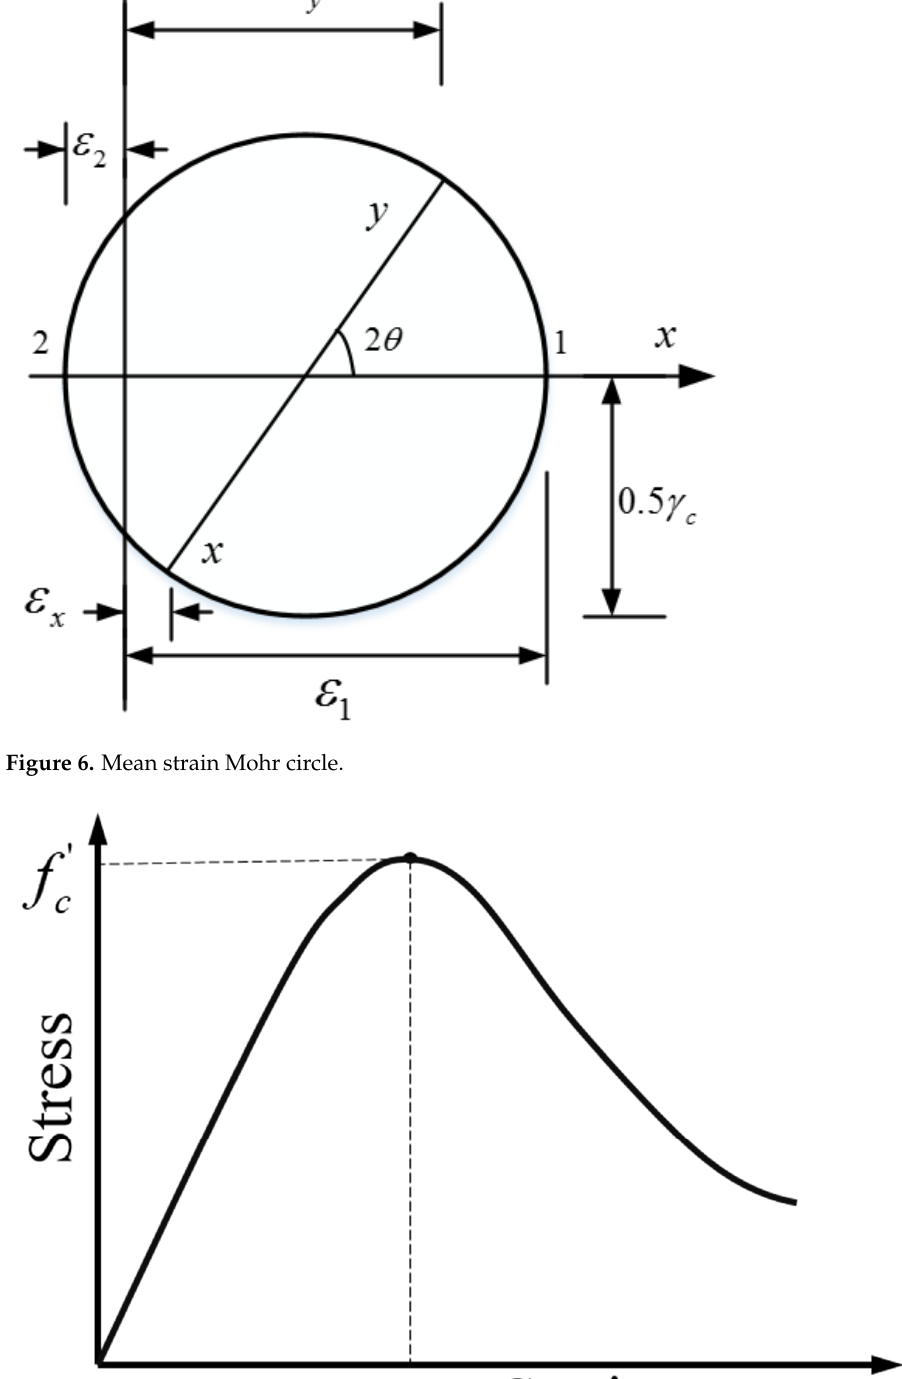
Figure 7. The stress-strain relationships of concrete.